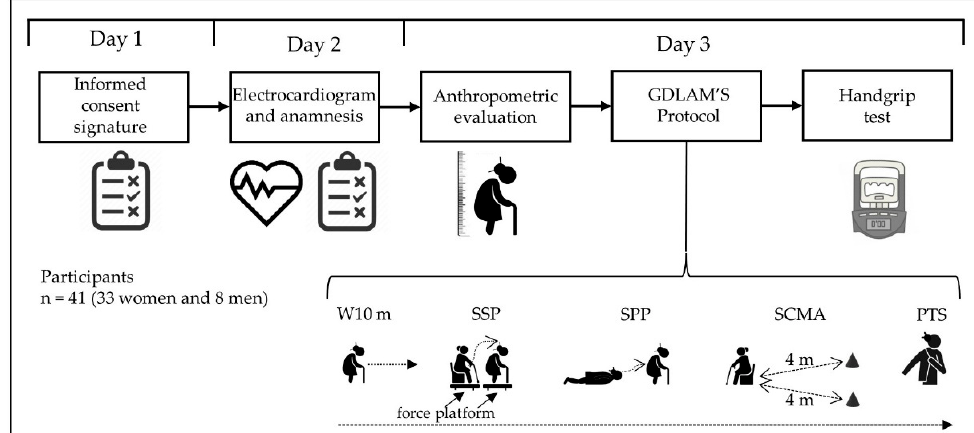
Figure 1. Research